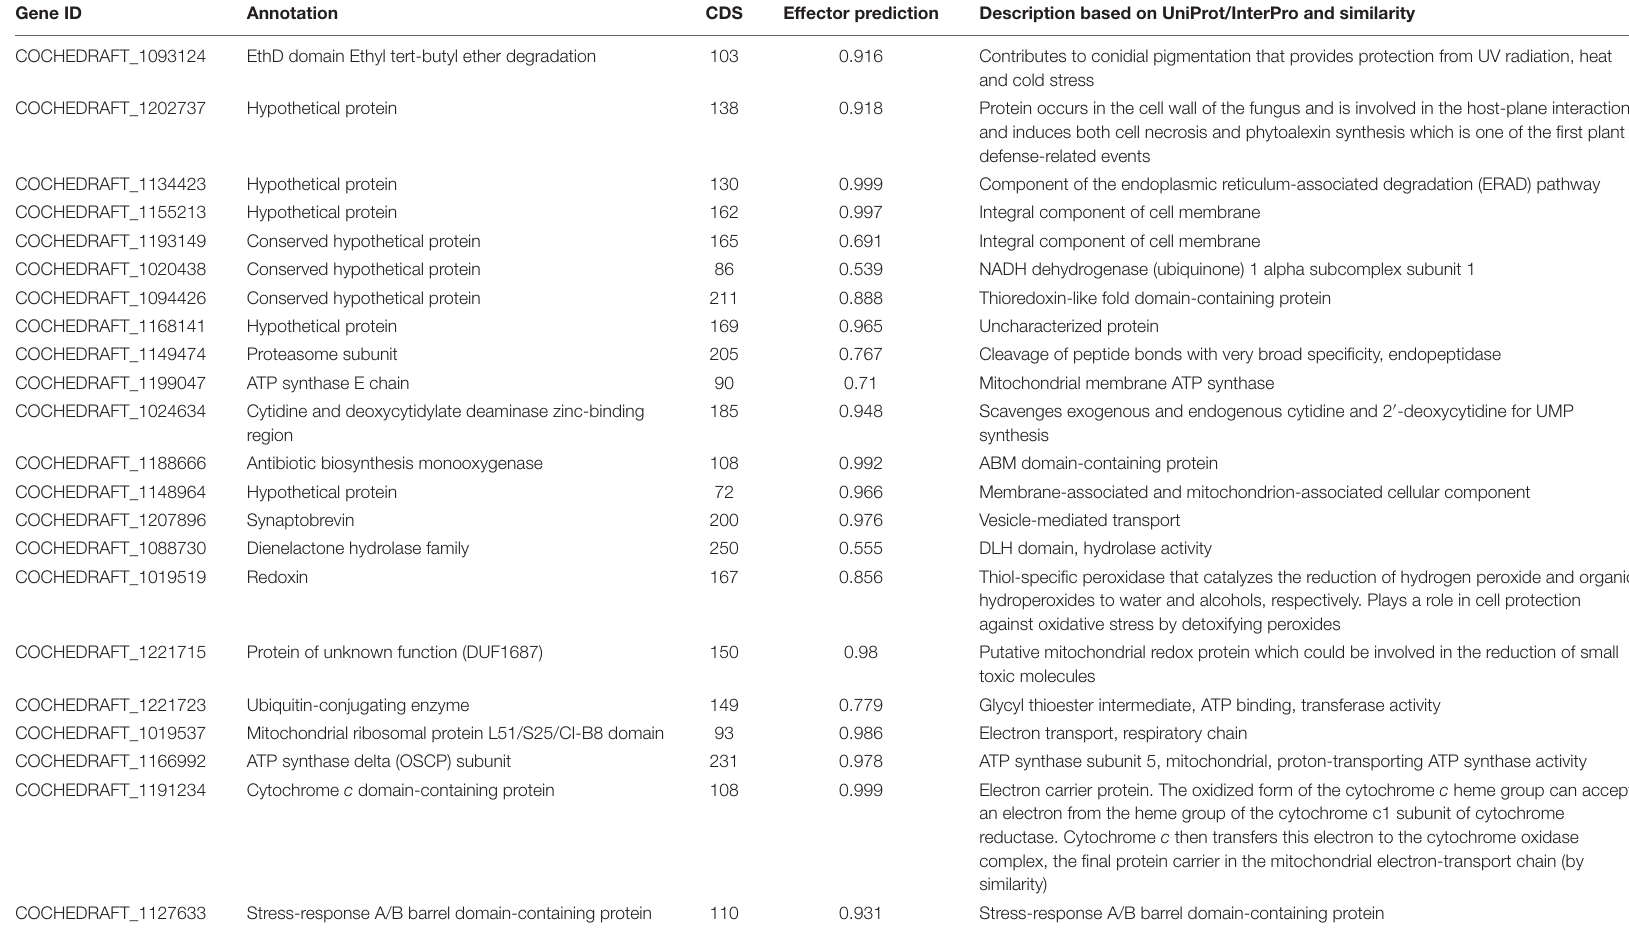
TABLE 5 | List of candidate effector genes identified in B. maydis . Gene ID